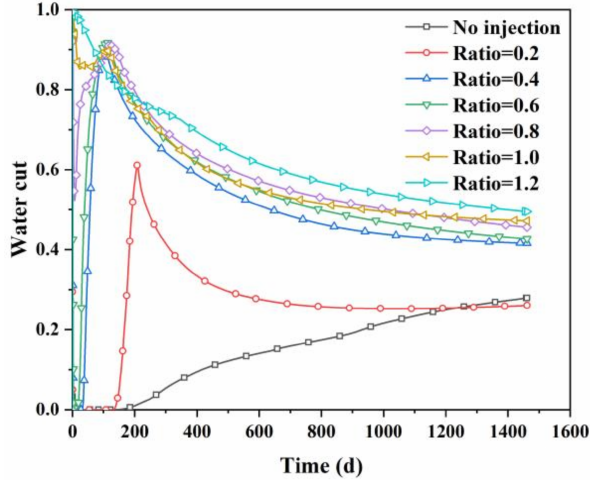
Figure 16. Water cut of parent